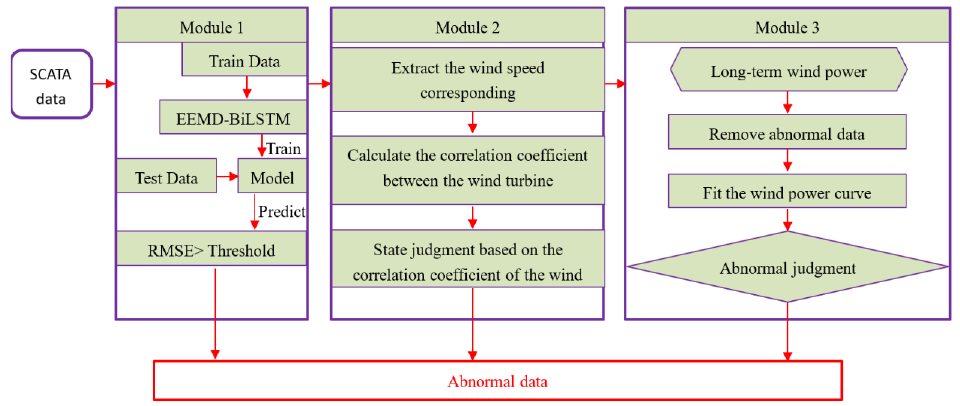
Figure 12. Framework of the integration of the collaborative anomaly detection schemes.